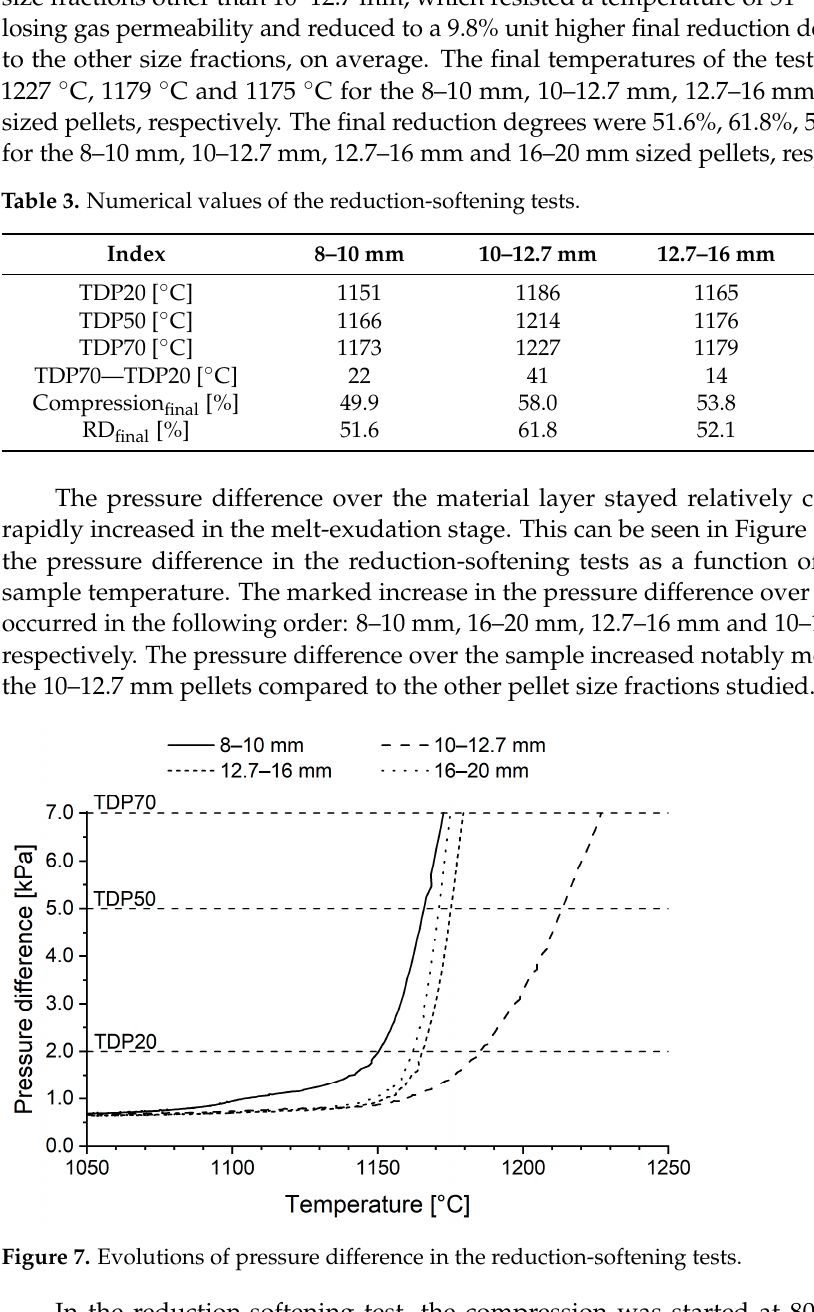
Figure 8. Evolutions of compression in the reduction-softening tests. After the reduction-softening experiments, the samples were photographed (see Fig- ure 9). The orientation in the image is similar to the orientation in the test device; thus, the reducing gases have gone through the burden from bottom to top. The top part in the 10–